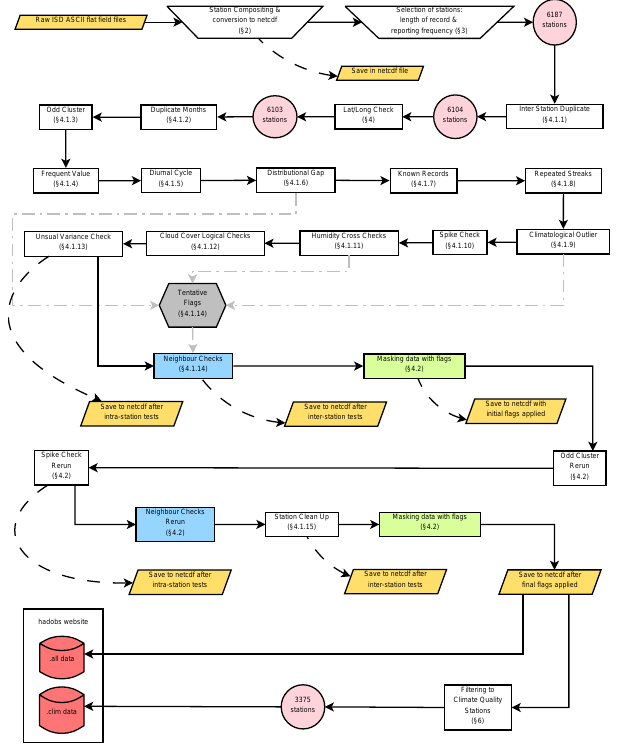
Fig. 3. Flow diagram of the testing procedure. Final output is avail- able on www.metoffice.gov.uk/hadobs/hadisd. Other outputs (yel- low trapezoids) are available on